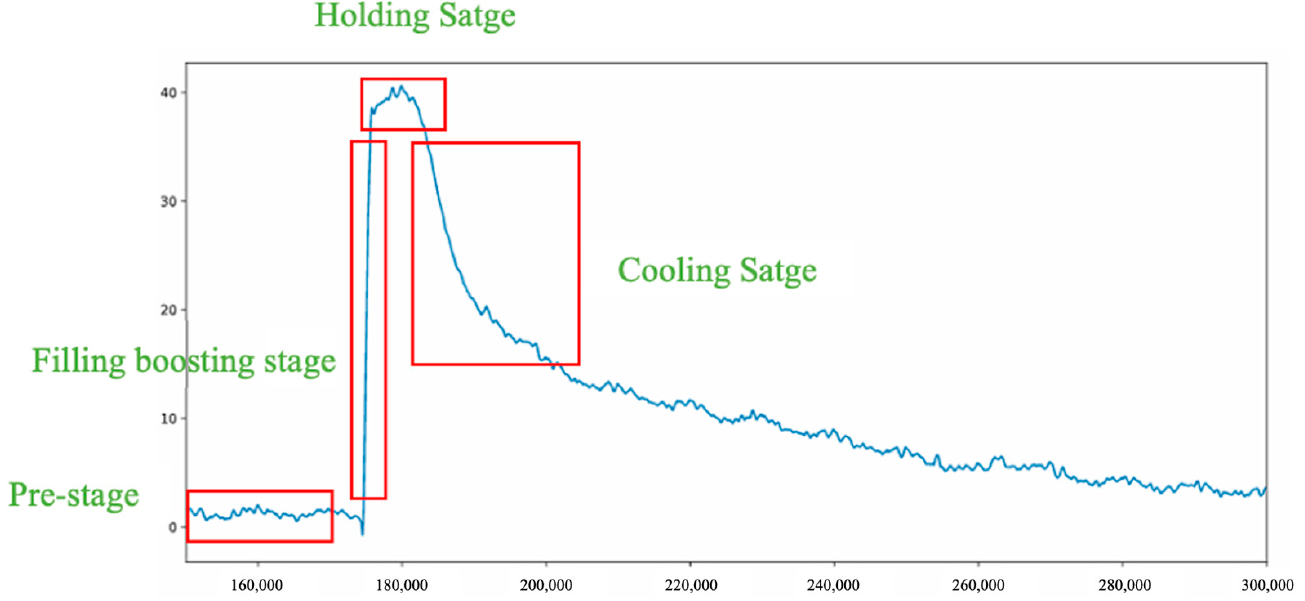
Figure 15. Various stages of casting.